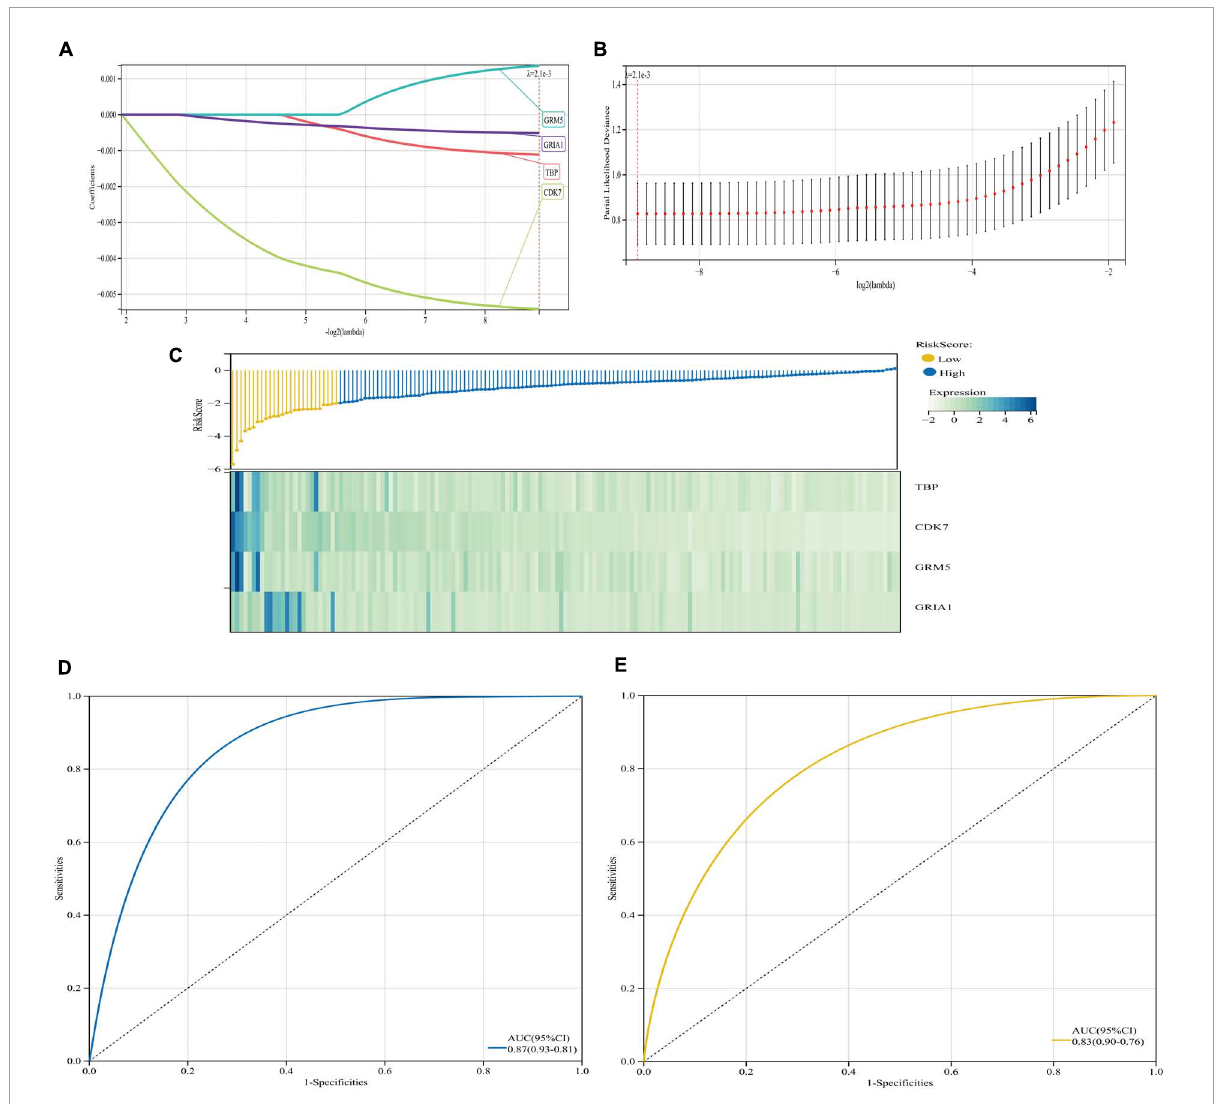
FIGURE12 Least absolute shrinkage and selection operator (LASSO) regression algorithm and model prognostic evaluation. (A,B) The model based on the GSE5281 dataset with four AD-related genes was determined by Lasso-Cox algorithm. (C) Heatmap of risk score distribution and prognostic 4 gene signatures in the GSE5281 database. (D,E) ROC curve and corresponding AUC value of two databases. (D) Database for model building GSE5281. (E) Database for validation